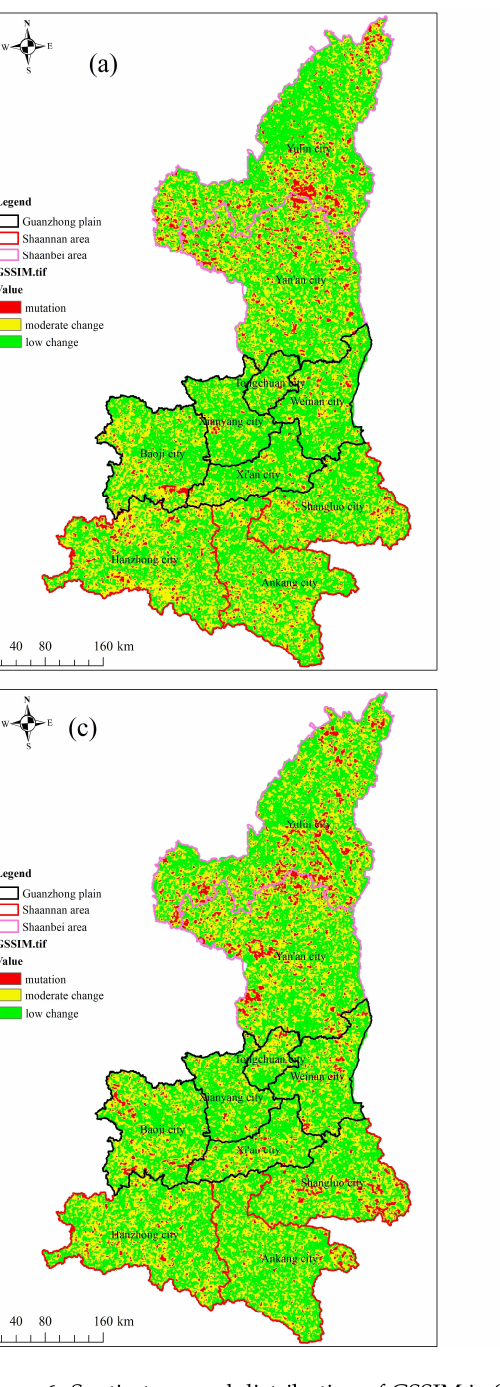
Figure 6. Spatio-temperal distribution of GSSIM in Shaanxi province. ( a ) 2000–2005; ( b ) 2005–2011; ( c ) 2011–2016; ( d ) 2000–2016.